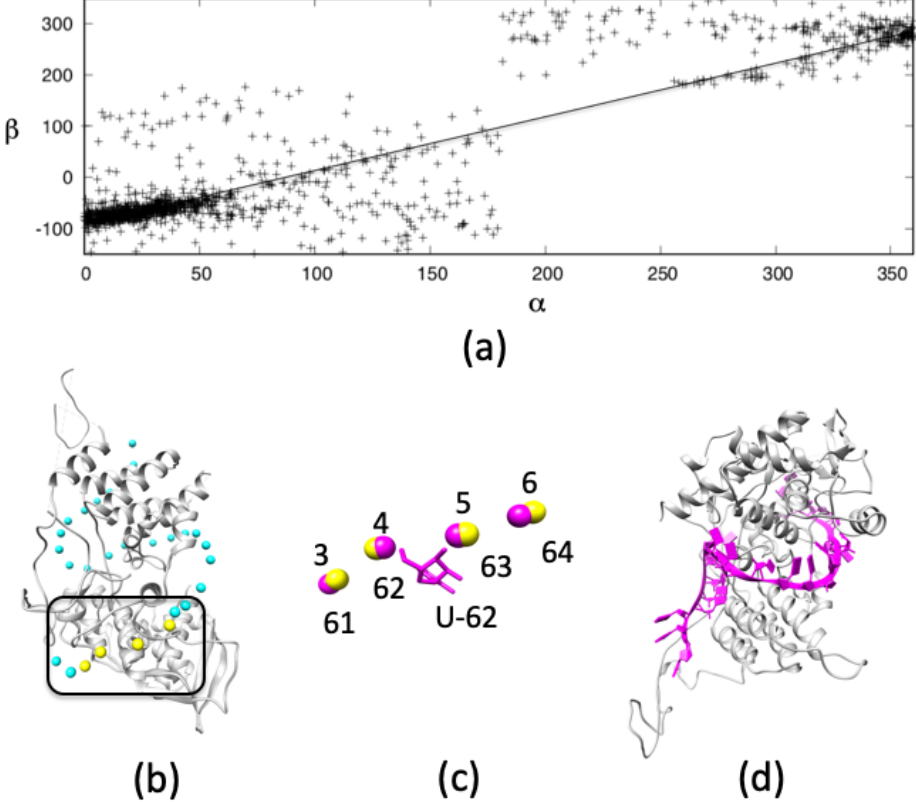
Figure 1. Single-stranded RNA structure prediction. ( a ) The α and β torsional angles for each nucleotide in T. thermophilus 30S rRNA shows a linear correlation, allowing an initial prediction of nucleobase orientation based on the backbone torsion. ( b ) Four target phosphorous atoms (in yellow) of vRNA at the NP surface align to the phosphorous atoms of a template structure (( c ), in magenta), from which the embedded nucleoside structure is derived. ( d ) By repeating this method across the NP surface a model of the vRNA is